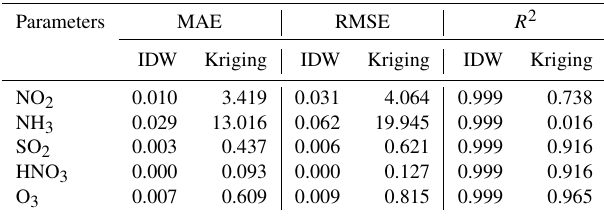
Table 2. Parameters of empirical semivariogram for each pollutant. NO 2 SO 2 HNO 3 O 3 Nugget Co (ppb) 2 30.90